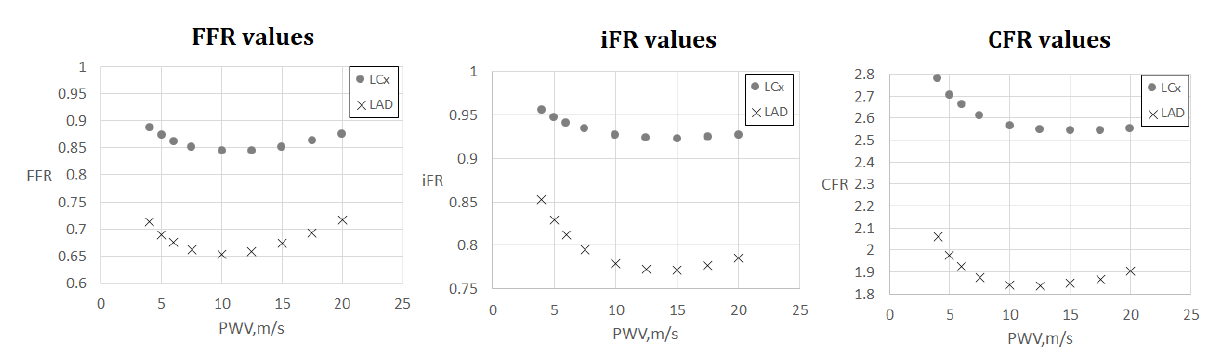
Figure 6. FFR, iFR and CFR sensitivity to AoPWV for patient 7. Patient 7 had two stenoses located in the left anterior descending artery (LAD) and the left circumflex artery (LCx).